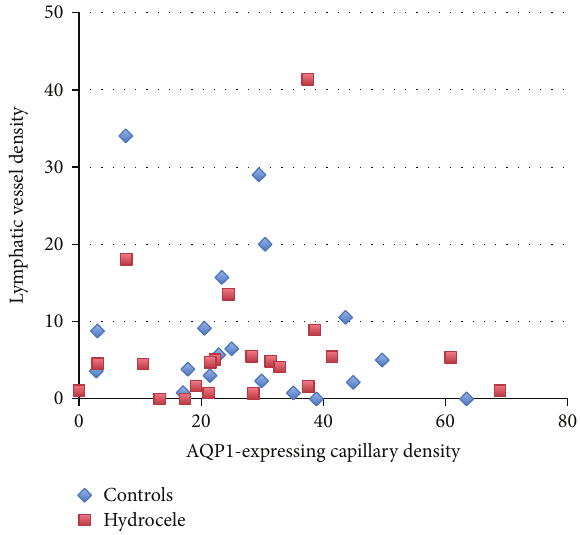
Figure 4: Scatter diagram of AQP1-expressing capillary density (counts/mm 2 ) and lymphatic vessel density (counts/mm 2